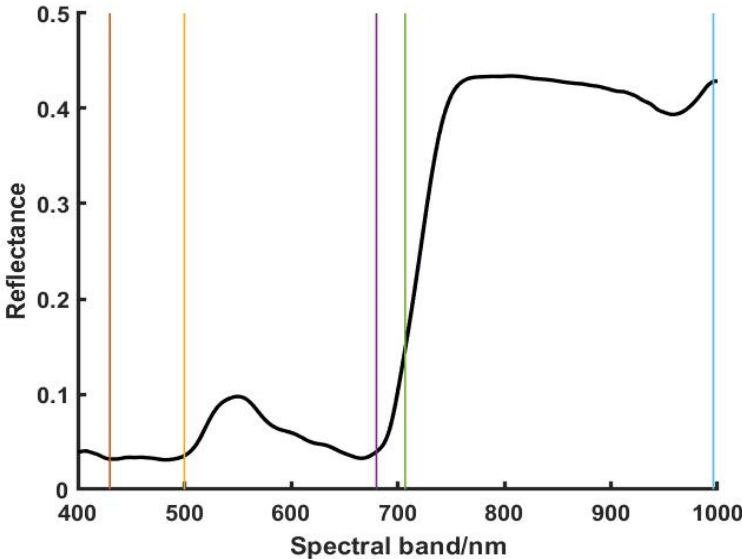
Figure 4. Rice hyperspectral reflectivity segment.